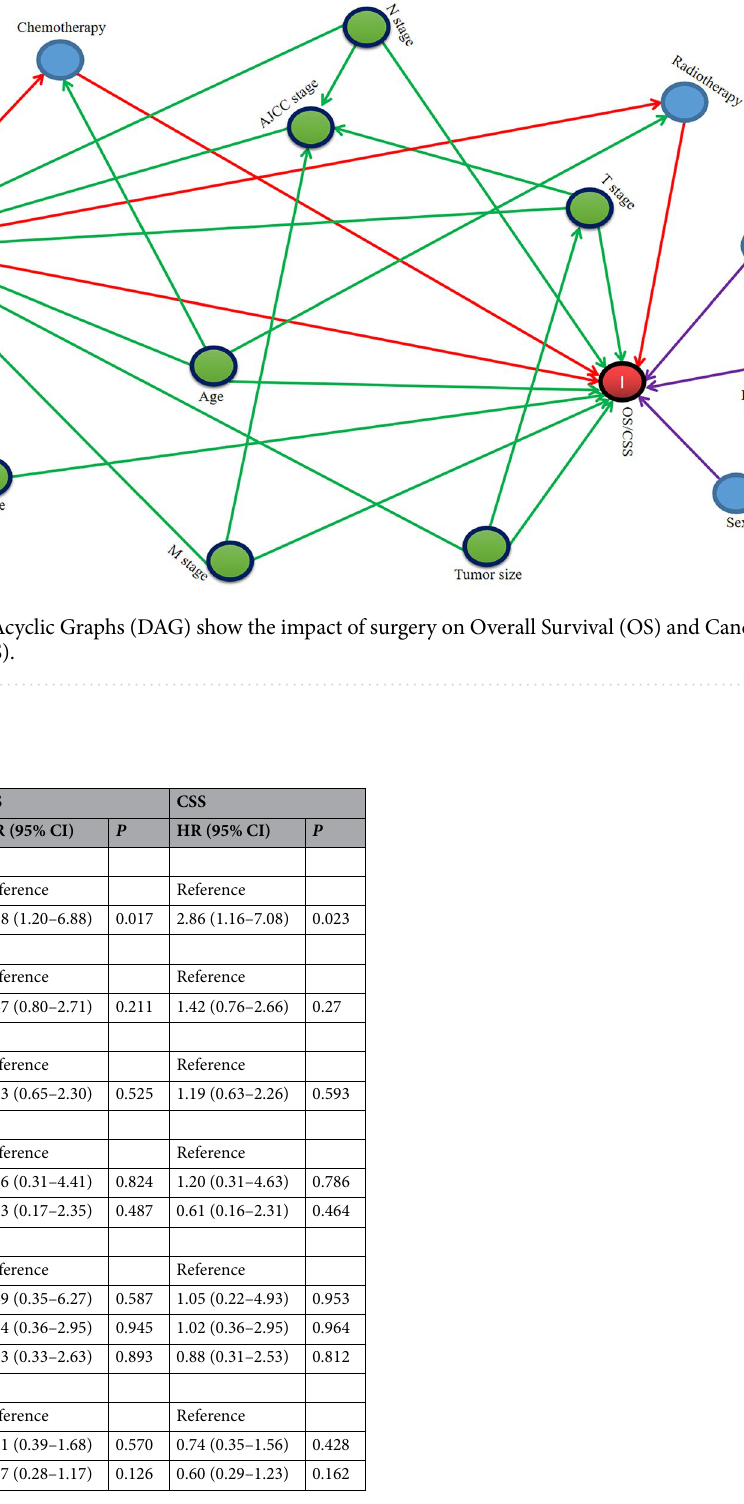
Table 4. DAG-Guided Multivariable Cox Regression Model Analysis for Causal Effect of Surgery on OS and CSS. CDC, renal collecting duct carcinoma; DAG, directed acyclic graphs; CI, confidence interval; HR, hazard ratio; OS, overall survival; CSS, cancer-specific